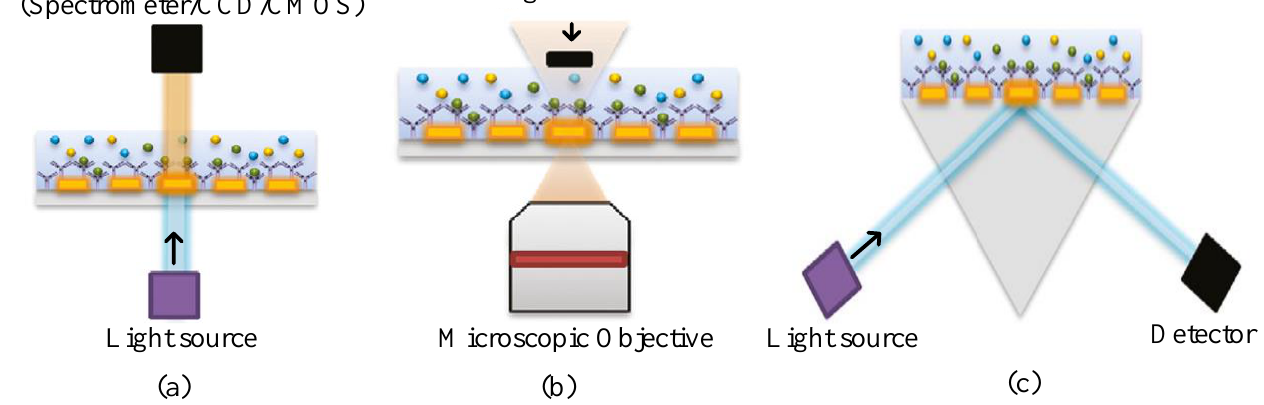
Figure 7. Diagrams illustrating nanoplasmonic-based biosensor setups: ( a ) extinction measurements, ( b ) dark-field microscopy, and ( c ) total internal reflection (TIR) microscopy. Figure adapted from [53].